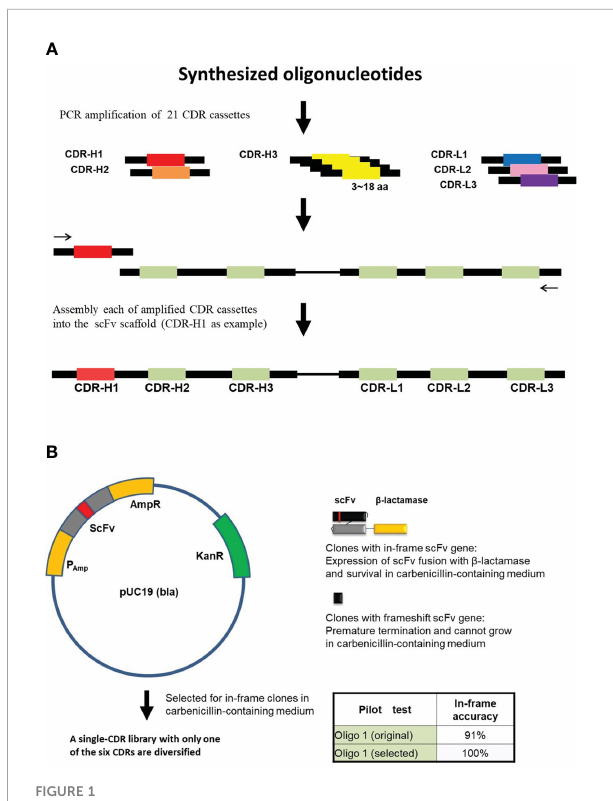
FIGURE 1 In-frame selection of assembled scFv repertoires. (A) Each of the CDR cassettes was ampli fi ed from synthesized oligonucleotides and then assembled into the scFv scaffold by PCR-based method (See “ Materials and Methods ” ). Assembly of CDR H1 is used as an example. (B) In-frame selection system, proofreading of the assembled scFv sequences using the pUC19 (bla) vector. The assembled scFv repertoire was inserted between the b -lactamase signal sequence and the N-terminus of the b -Lactamase. A single- CDR library with only one of the six CDRs diversi fi ed was constructed for each CDR and selected for in-frame clones in carbenicillin-containing medium. In-frame selection of CDR cassettes were performed one by one. Oligo 1, one of the synthesized